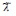
Effect of the number of trials involved in the estimation.A. Evolution of λ˜ for a different number of trials. Red circles indicate the result of the conjoint optimization, and red error bars indicate the standard deviation of the individual lambdas. Blue circles and blue error bars indicate the position of the minimum value of the CVD function for groups and individuals, respectively. B. Correlation between ACIs estimated on n trials, and final ACI (λ = 1,191). Dotted line: mean and standard deviation of the correlation for individual ACIs; thick line: correlation for the mean ACI for the participants collectively.